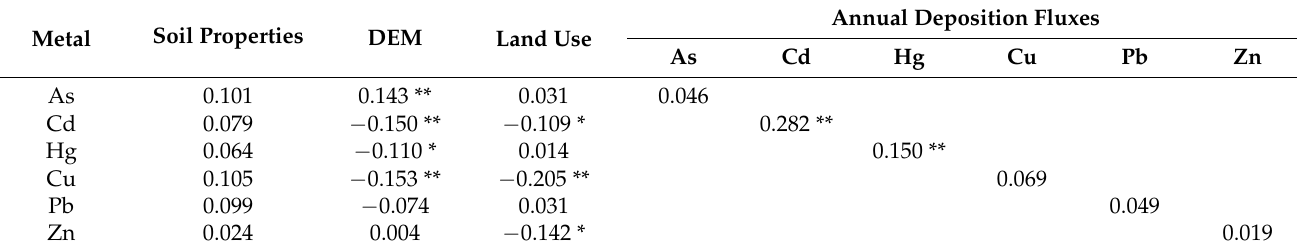
Table 5. The correlation analysis results of heavy metal concentrations and influencing factors.